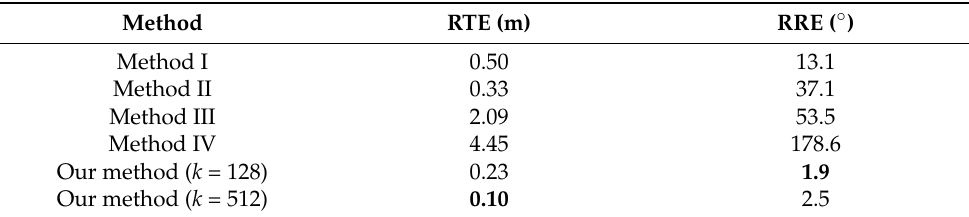
Table 6. Registration results of each method from scan #25 to scan #24 in Dataset